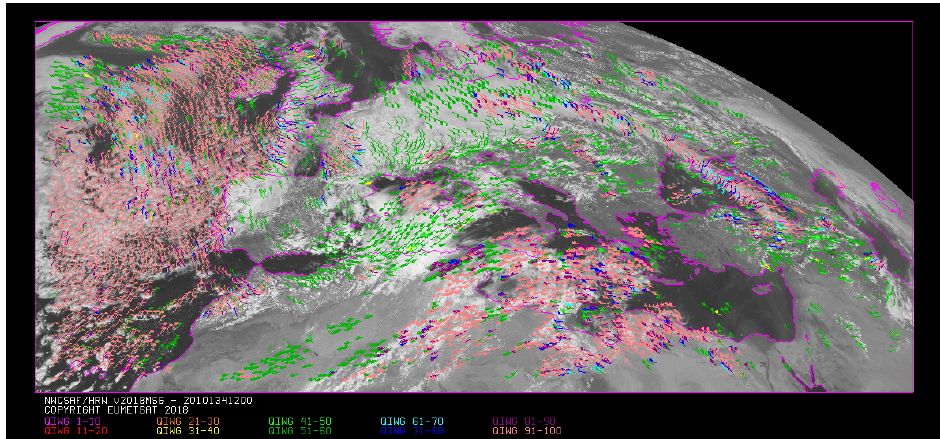
Figure 12. Common quality indicator without forecast values, for the NWC / GEO-HRW example for the European and Mediterranean region, with the default conditions for MSG satellites (14 May 2010, 12:00 UTC, MSG-2 satellite). The di ff erences with Figure 11, and the fact that not all AMVs have a valid value for the common quality indicator without forecast are to be noticed.